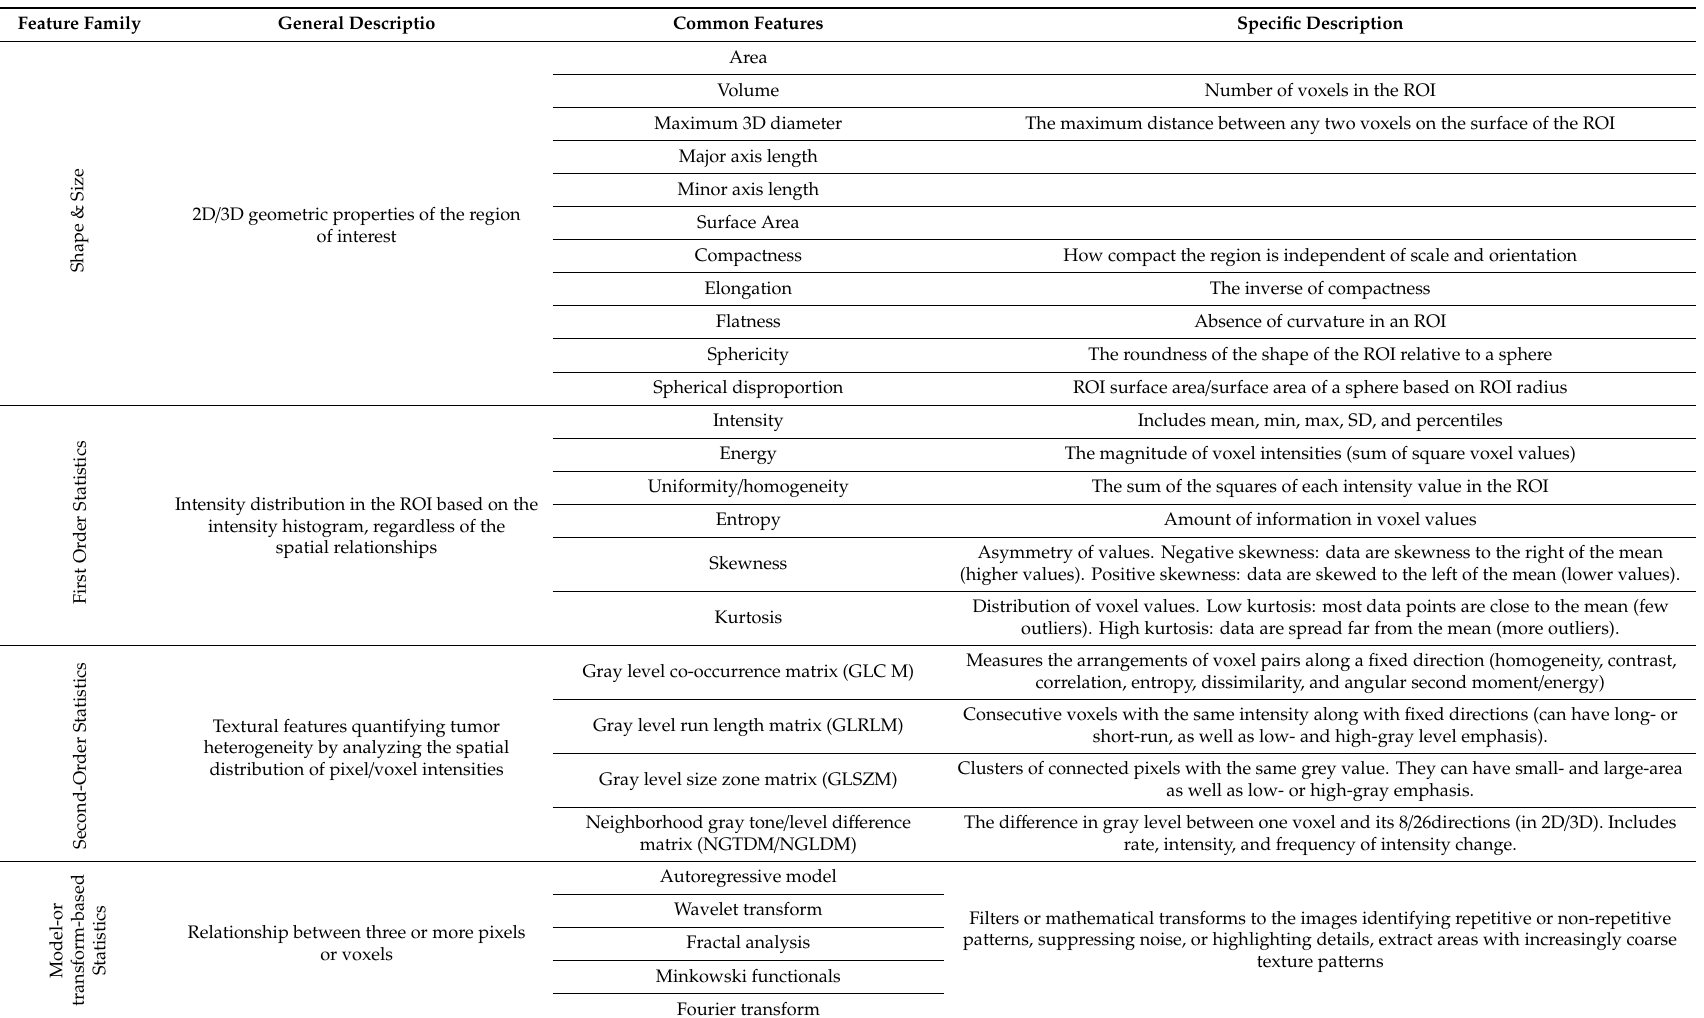
Table 3. Overview of the analyzed radiomic